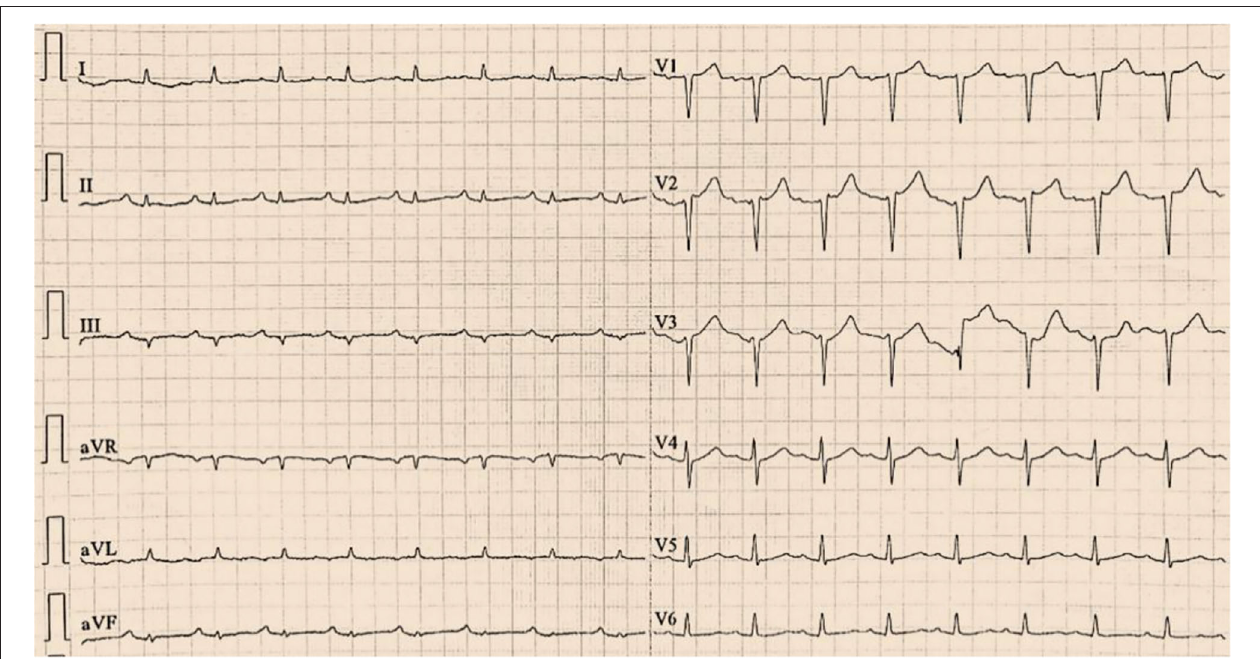
FIGURE 4 | The postoperative electrocardiogram indicated ST-segment elevation in leads II, III and aVF disappeared.